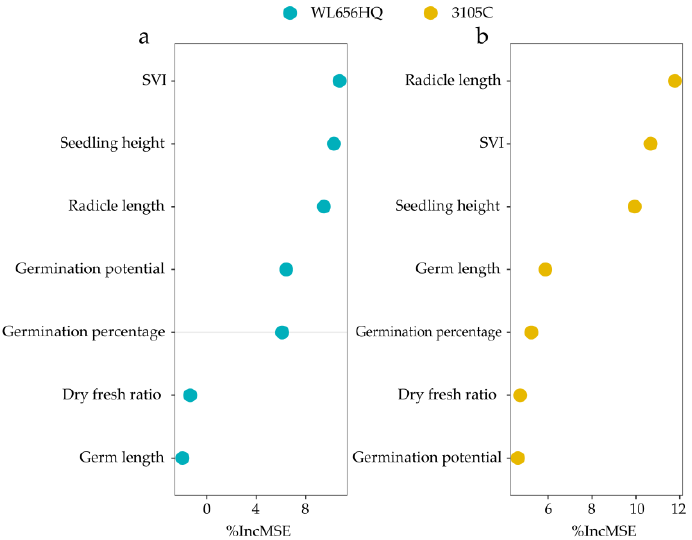
Figure 2. The relative importance of variables affecting the comprehensive allelopathic index of sensitive and tolerant alfalfa varieties. ( a ) Blue indicates the index ranking of the autotoxicity-tolerant variety WL656HQ affecting the comprehensive allelopathy index. ( b ) Yellow indicates the index ranking of the autotoxicity-tolerant variety 3105C affecting the comprehensive allelopathy index.